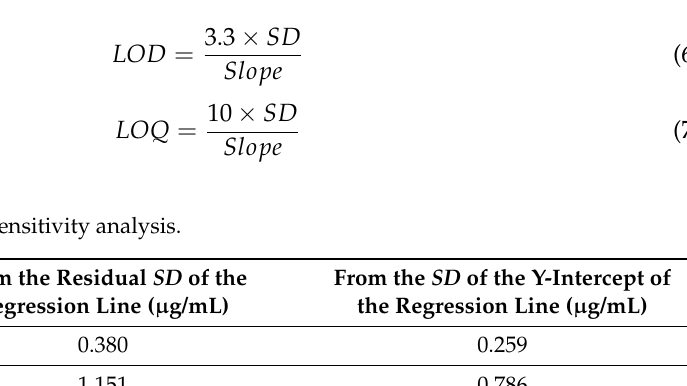
From the SD of the Y-Intercept